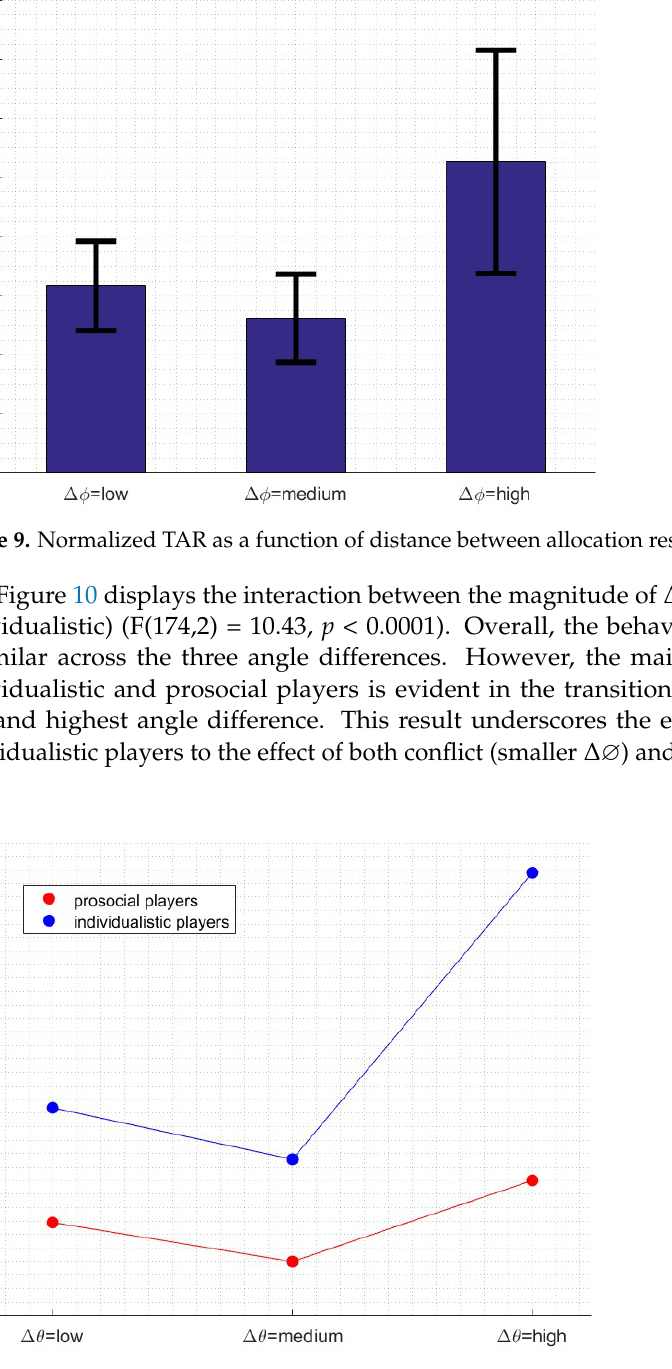
Figure 10. The interaction between SVO category and ∆ ∅ size for normalized TAR.